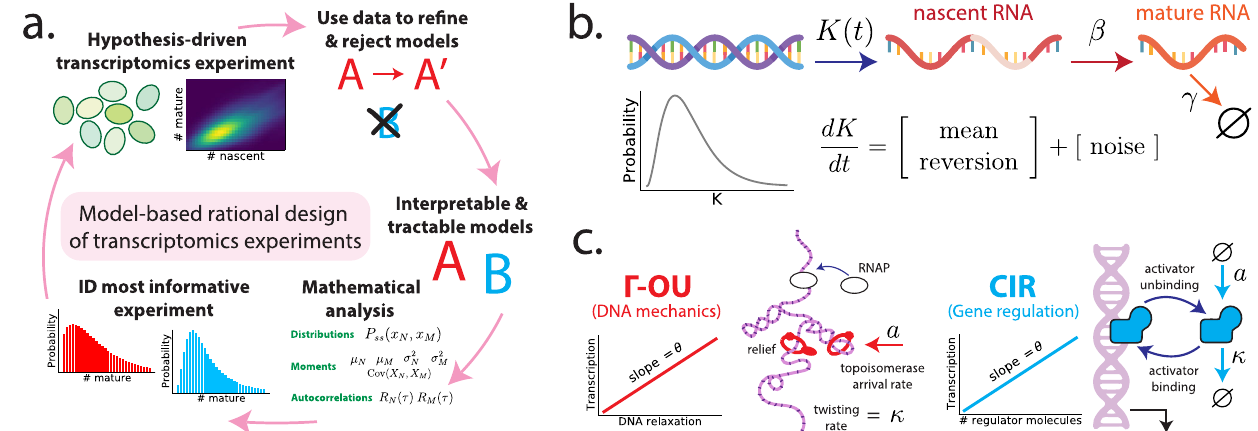
and time-varying transcription rate K ( t ). The transcription rate is assumed to evolve in time according to a simple, one-dimensional SDE that includes a mean- reversionterm(which tendsto push K ( t ) towardsits meanvalue) and a noise term (which causes K ( t ) to randomly fl uctuate). Here, we have speci fi cally chosen dynamics for which the long-time probability distribution of K ( t ) is a gamma dis- tribution (gray curve), because this assumption yields empirically plausible nega- Cox – Ingersoll – Ross (CIR) model describes regulation by a high copy